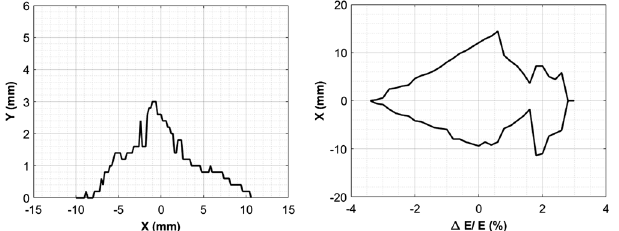
FIG. 25. Transverse dynamic aperture with synchrotron oscil- lations (left) and energy acceptance ( Y 0 ¼ σ y ¼ 4 . 243 μ m and rf is OFF) (right) for alternative optics. Fig. 24. The obtained normalized brightness of the alter- native lattice is Br = Br ¼ 0 . 69 (Fig. 23 denoted as DT). max